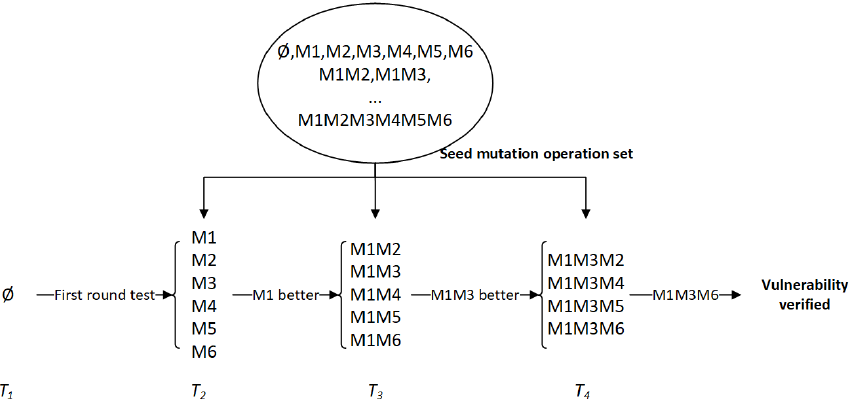
Figure 8 . An example of seed mutation